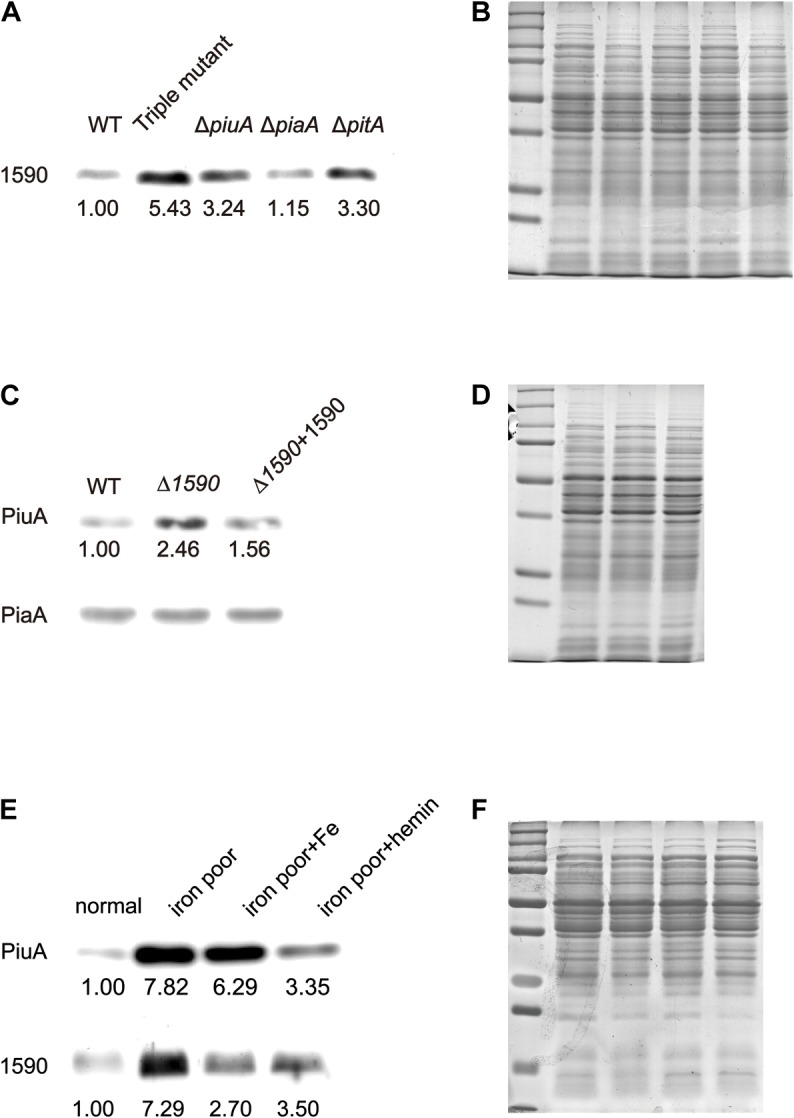
The expression of SPD_1590 is regulated by hemin. (A) The expression of SPD_1590 in WT, Triple mutant, ΔpitA, ΔpiaA, and ΔpiuA mutant D39 strains. (C) The expression of PiuA and PiaA in WT, Δ1590, and Δ1590+1590 mutant D39 strains. (E) The expression of SPD_1590 and PiuA of WT D39 cultivated in normal, iron-poor, iron-poor+Fe, iron-poor+hemin media. (B,D,F) Total proteins were used as loading controls of the western blotting experiments as shown in (A,C,E), respectively.